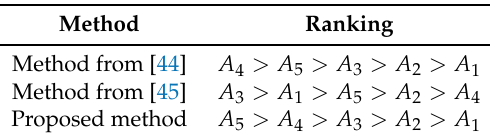
Table 8. Results of different